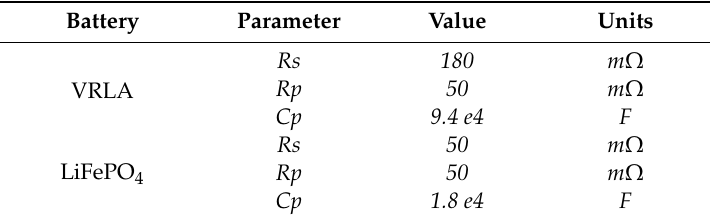
Table 1. ECM parameters for each chemistry.